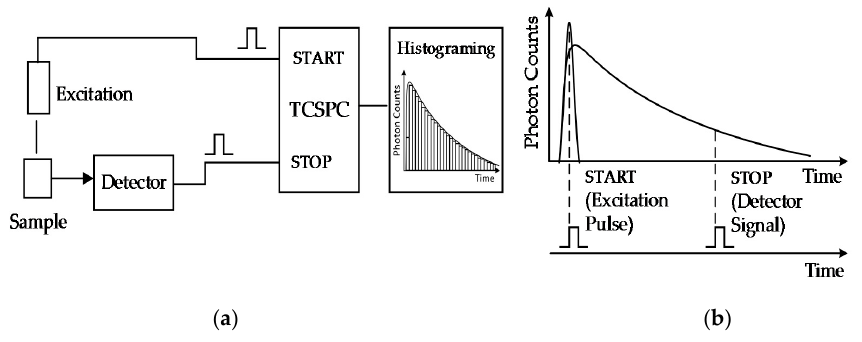
Figure 2. Time-correlated single photon counting (TCSPC) operation principle. ( a ) System schematic; ( b ) timing diagram of the start-stop watch mode [29].